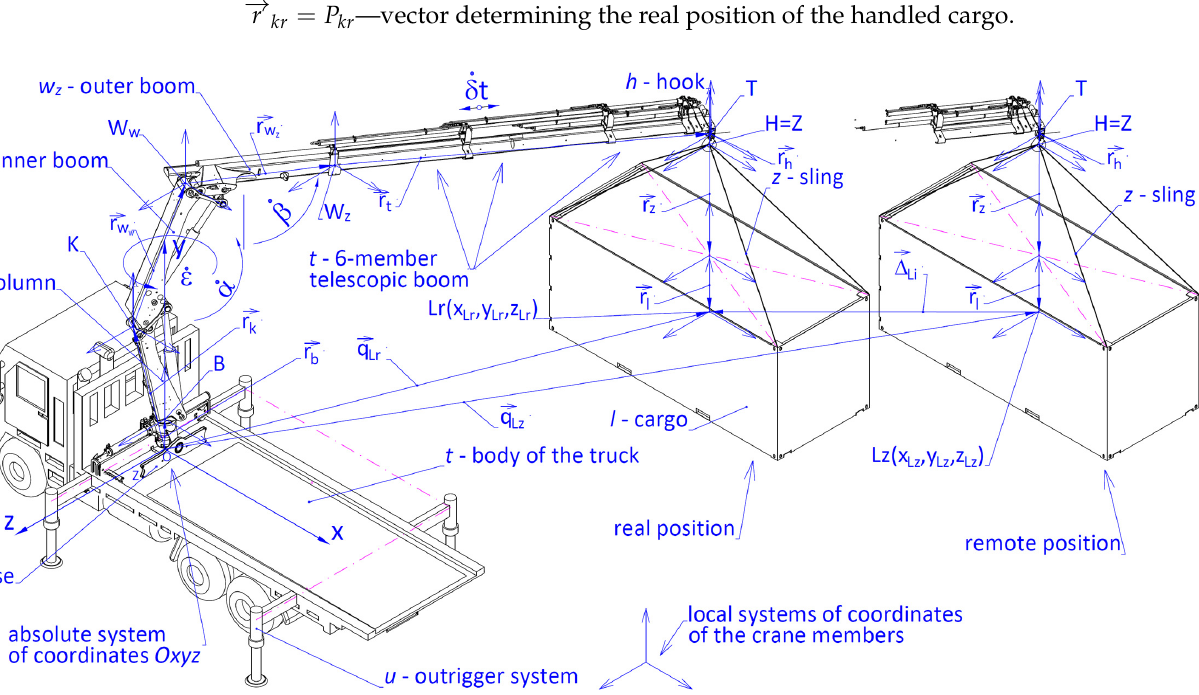
Figure 8. Spatial dimensional chain of the crane system where: accuracy of positioning the cargo handling crane after completing i th sequential movement of the −→ r kr —vector determining the real position of the cargo, working member, the set (nominal) position of the